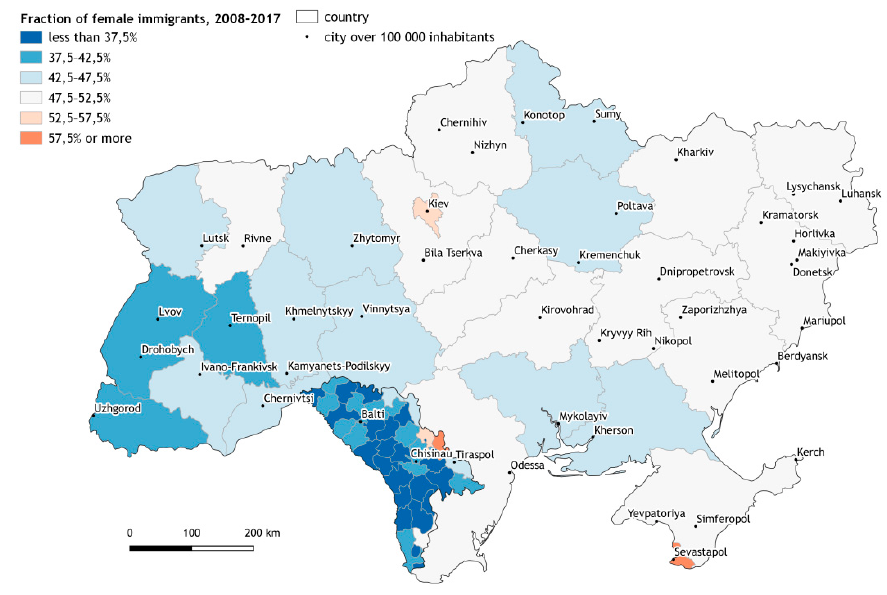
Figure 6. Fraction of female immigrants into Czechia from Ukraine (by oblast) and Moldova (by raion), including both permanent and temporary residence permits. Source: our own research.